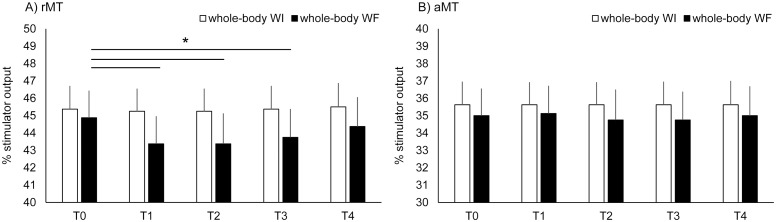
rMT and aMT for each intervention.White and black bars show the period of whole-body WI and WF, respectively. Asterisks (*) indicate significant differences (p<0.05) compared with T0.